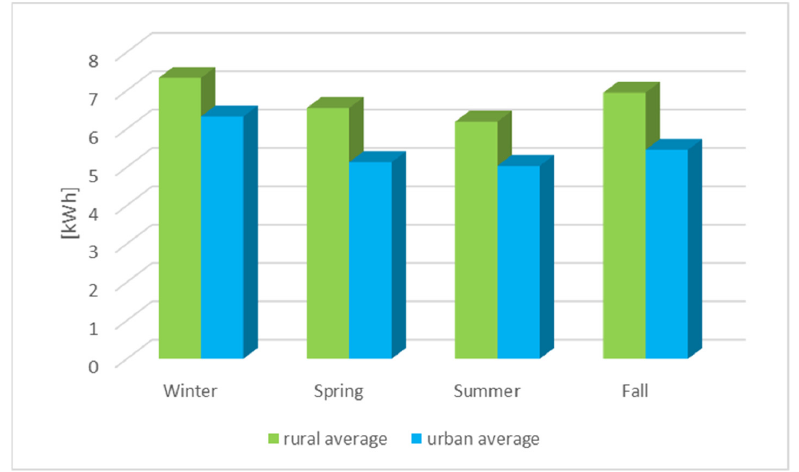
Figure 9. Rural vs. urban meteorological season consumption patterns.